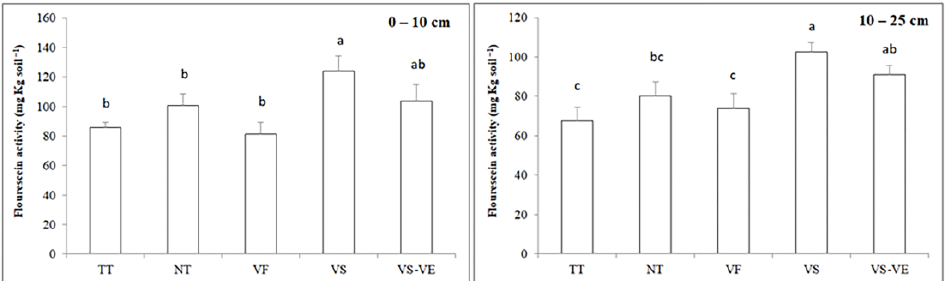
Figure 6. Average soil microbial activity in relation to soil management strategies applied in almond orchards. TT, traditional tillage; NT, no tillage; VF, cover of V. faba ; VS, cover of V. sativa ; VS-VE, cover of V. sativa and V. ervilia . Bars are standard deviation. Different letters indicate significant differences between management strategies by Tukey’s test, p < 0.05.